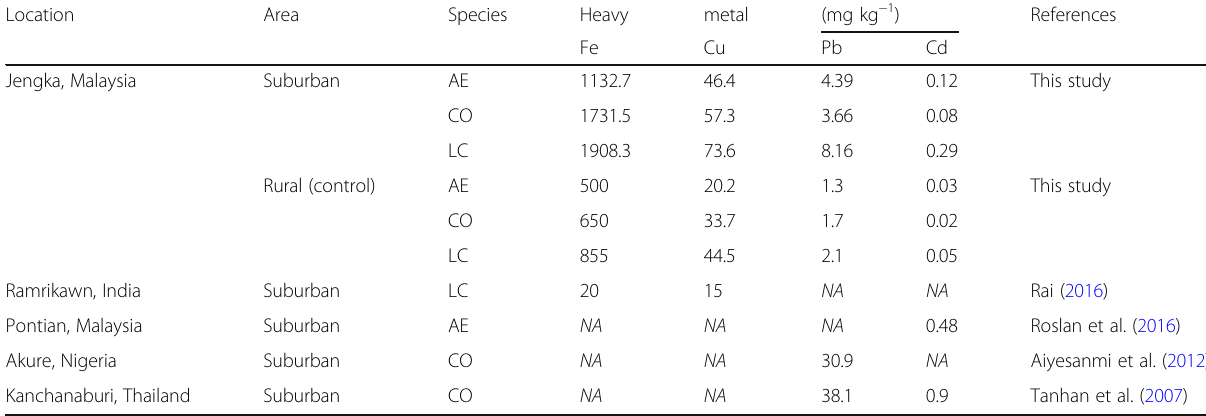
Table 2 Comparison of metal concentrations (mg kg − 1 ) in roadside plants from this study with data available from some previous studies Location